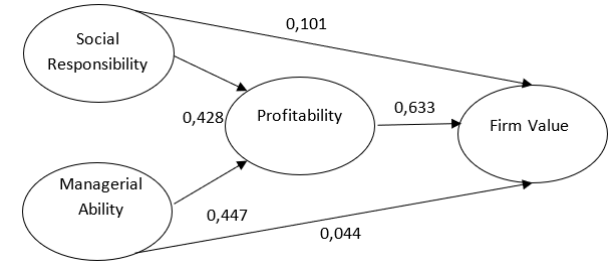
Figure 2: Diagram Path; Source: Primary data processed,